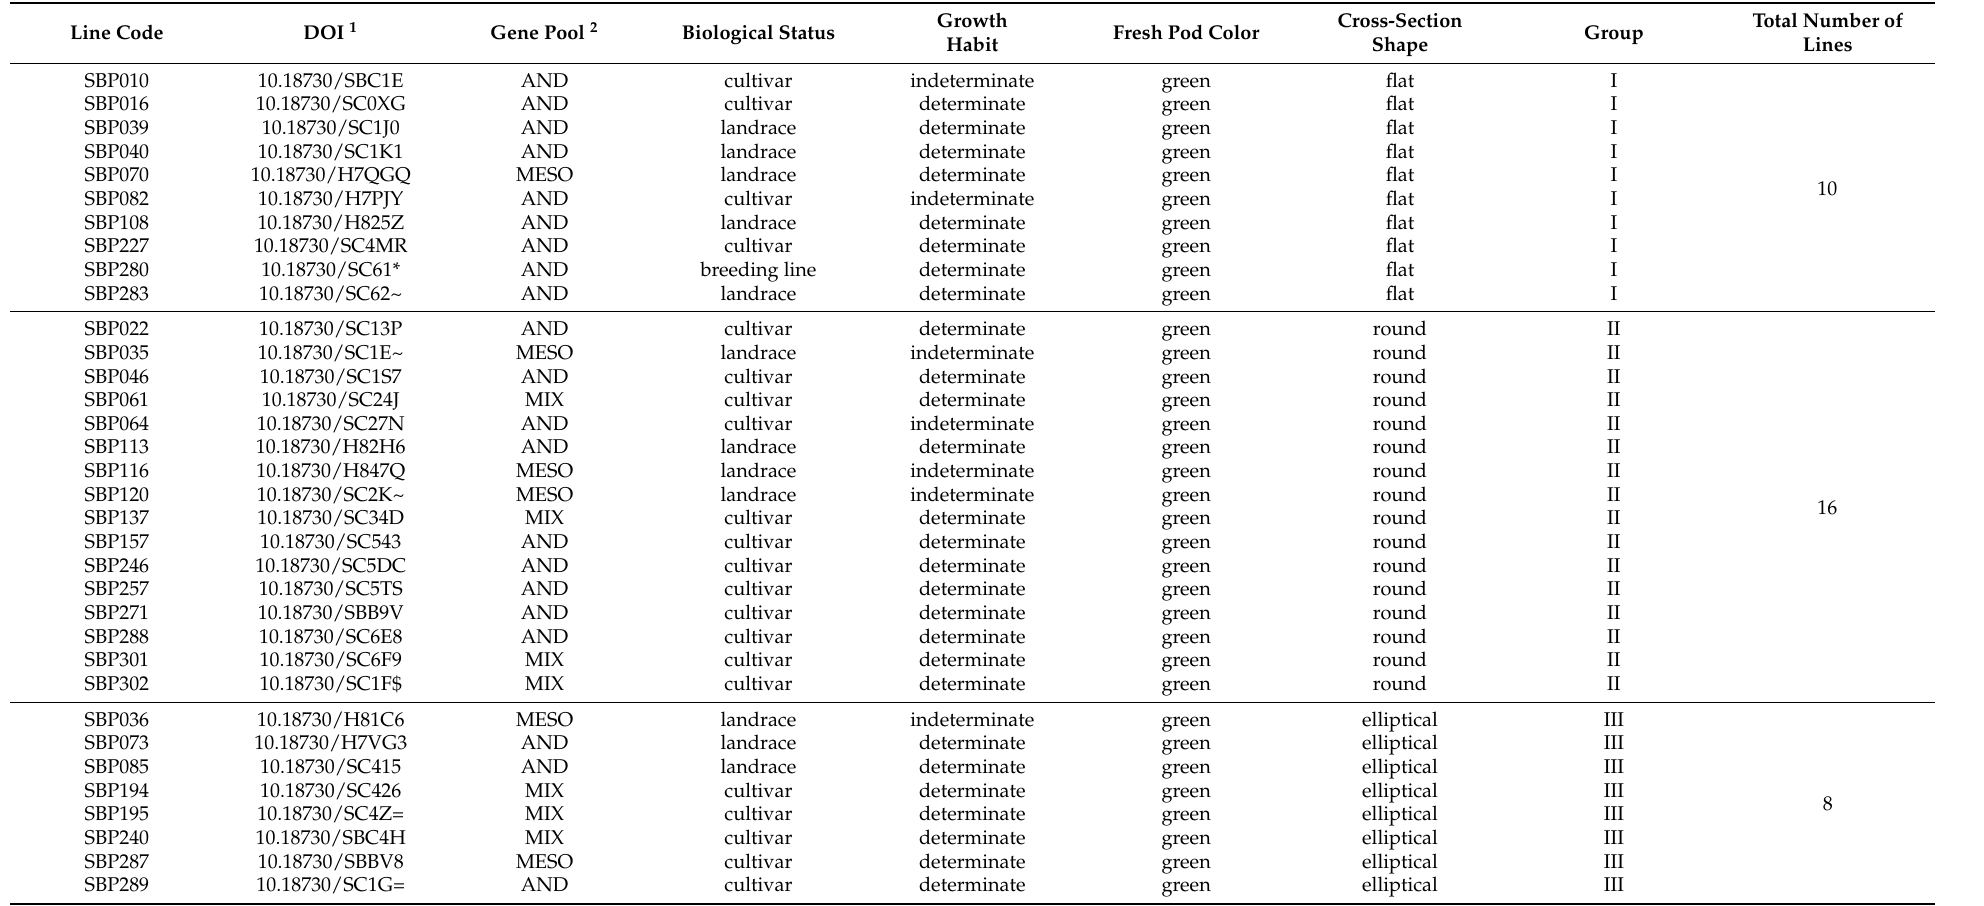
Table 1. List of the 54 snap bean lines, along with passport information and classification according to pod phenotype (pod color and cross-section